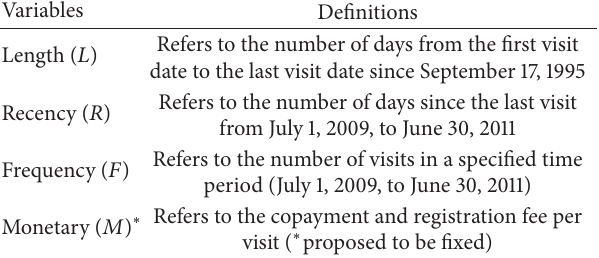
Table 1: The definitions of LRFM model.